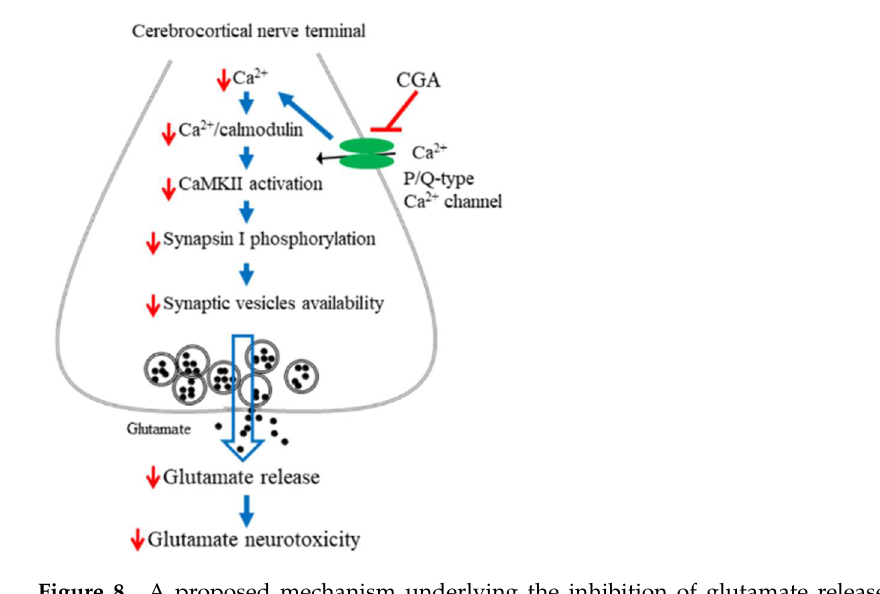
Figure 8. A proposed mechanism underlying the inhibition of glutamate release by CGA. In rat cerebrocortical nerve terminals, CGA direct suppresses P/Q-type Ca 2+ channels, leading to CaMKII/synapsin I pathway suppression and glutamate release reduction. This effect might con- tribute to the neuroprotection against KA-induced cortical neuronal damage.